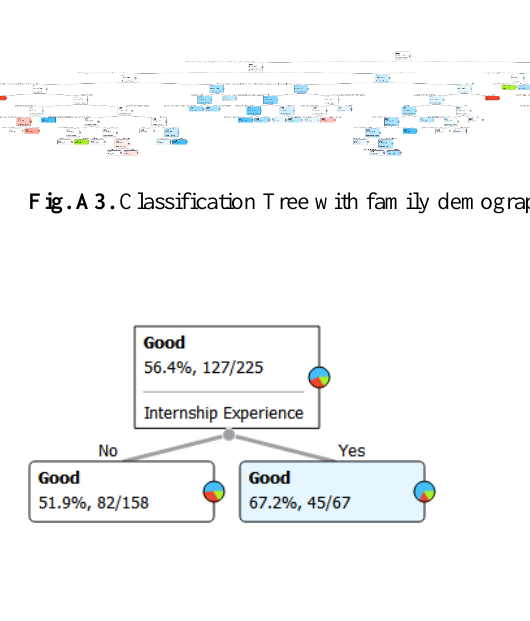
Fig. A4. Classification Tree with internship experience